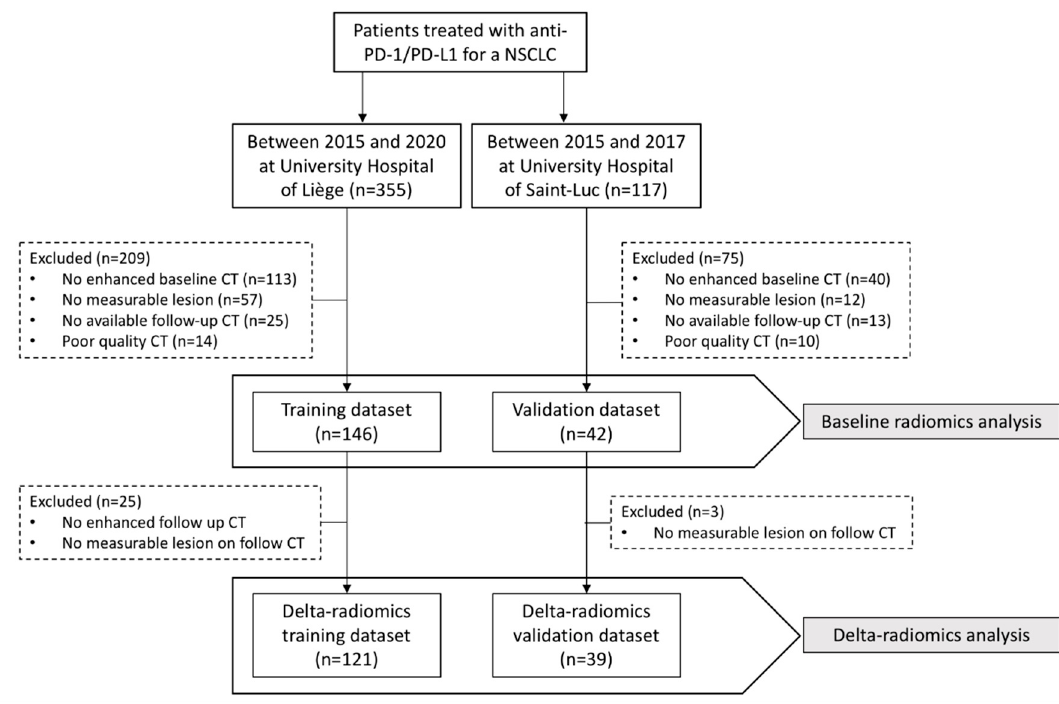
Figure 2. Patient flow diagram.